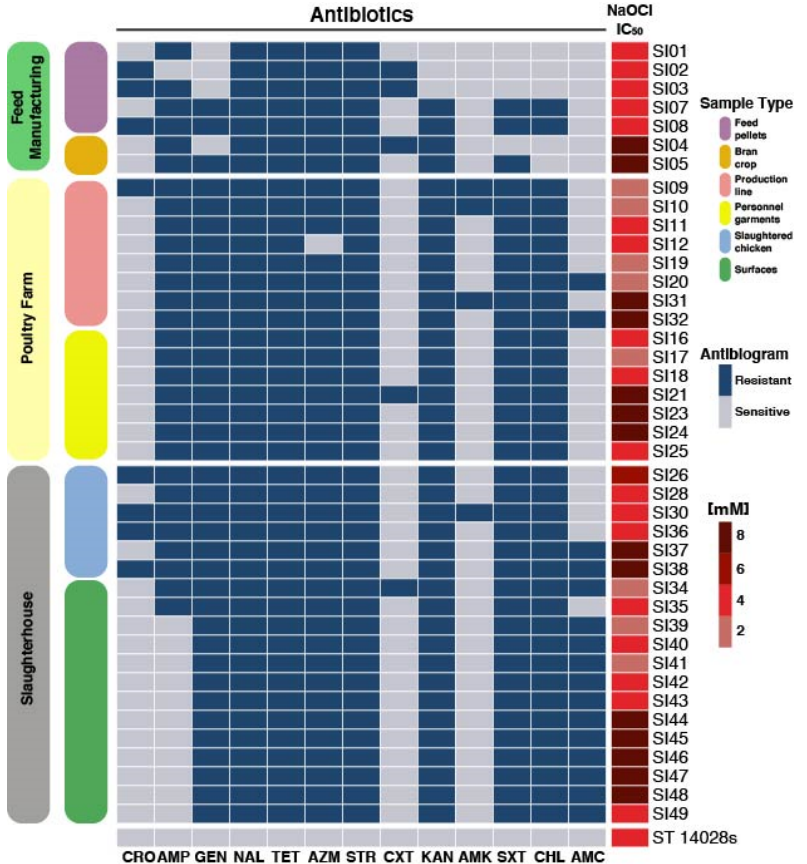
Figure 2. Antibiotic resistance profile of each S. Infantis strain (SI01–SI19) tested (AMP: ampicillin, STR: streptomycin, NAL: nalidixic acid, TET: tetracycline, AZM: azithromycin, CHL: chloramphenicol, KAN: kanamycin, GEN: gentamicin, SXT: sulfamethoxazole/trimethoprim, AMC: amoxicillin-clavulanic acid, CXT: ceftriaxone, CRO: ciprofloxacin, AMK: amikacin) according to their production stages origin. The IC 50 value to NaOCl is also shown for each strain. The Salmonella Typhimurium 1028s strain (ST 14028s) was used as reference.